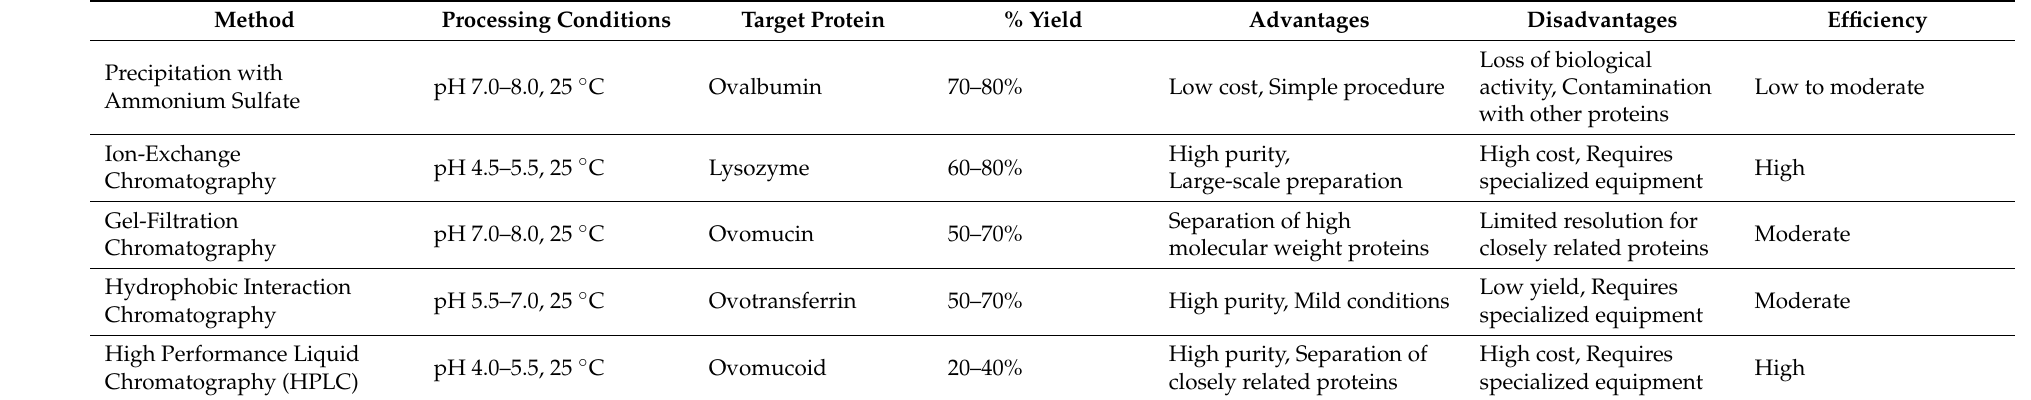
Table 1. Methods for fractionating the primary proteins in egg